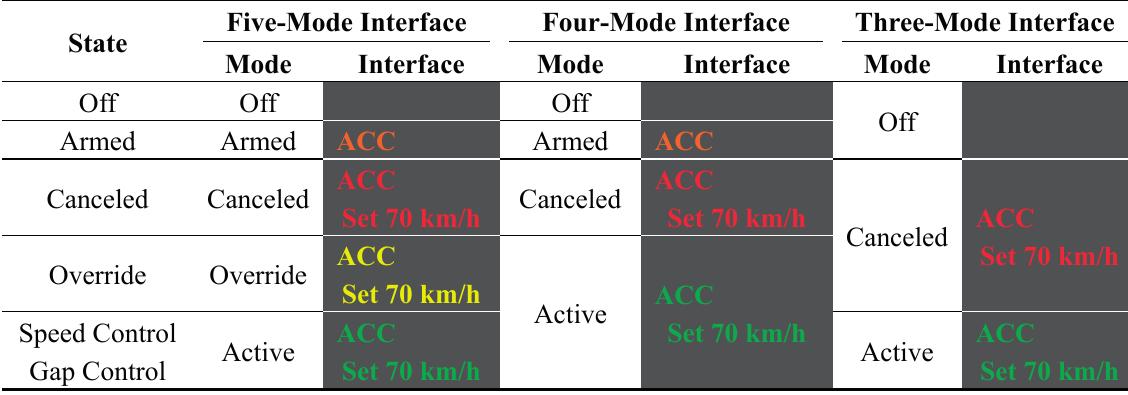
Figure 10. Graphical user interface for the ACC system implemented based on current interfaces. Table 6. Graphical user interfaces based on the traditional and new interface models for the ACC